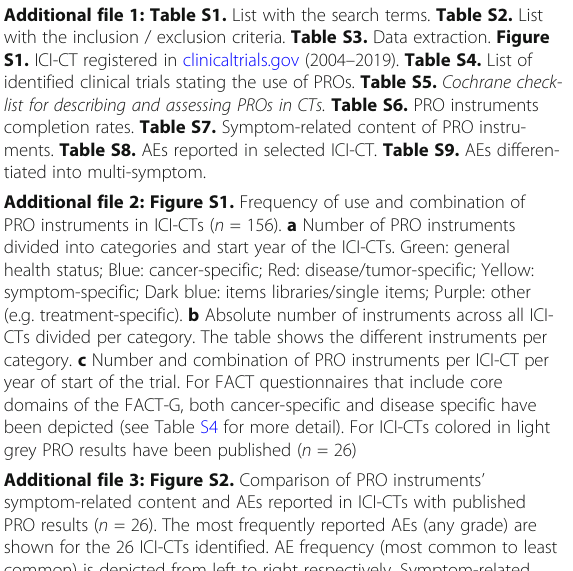
Additional file 1: Table S1. List with the search terms. Table S2. List with the inclusion / exclusion criteria. Table S3. Data extraction. Figure